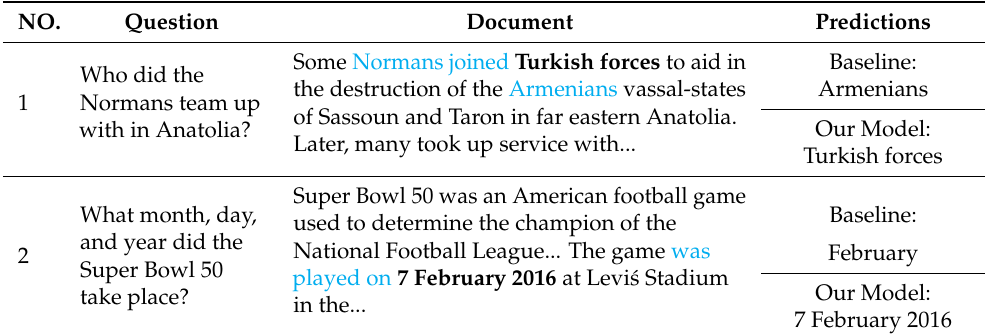
Table 5. A case study for BERT -base (Baseline) and BART- base RL\w F1 (Our Model) on SQuAD dataset ∗ .